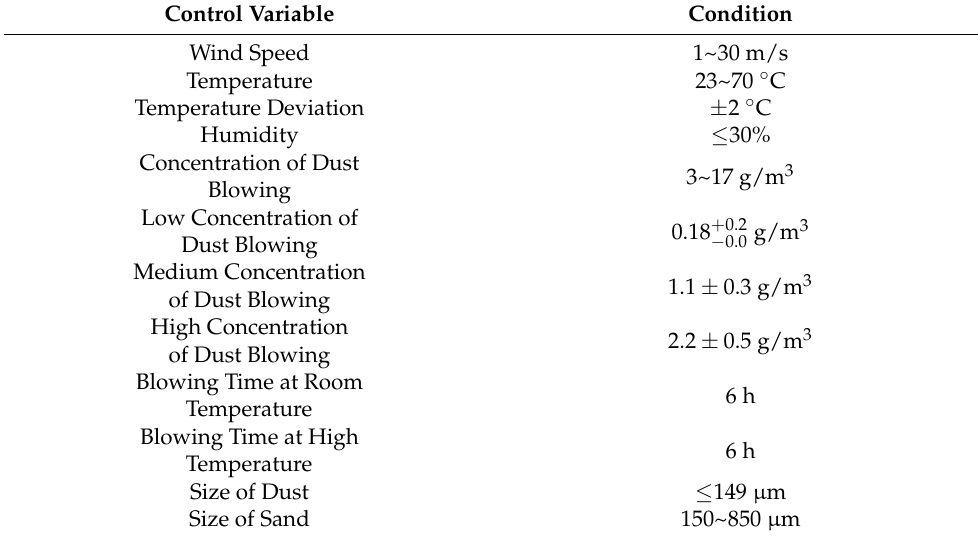
Table 3. Experimental conditions of the control system.